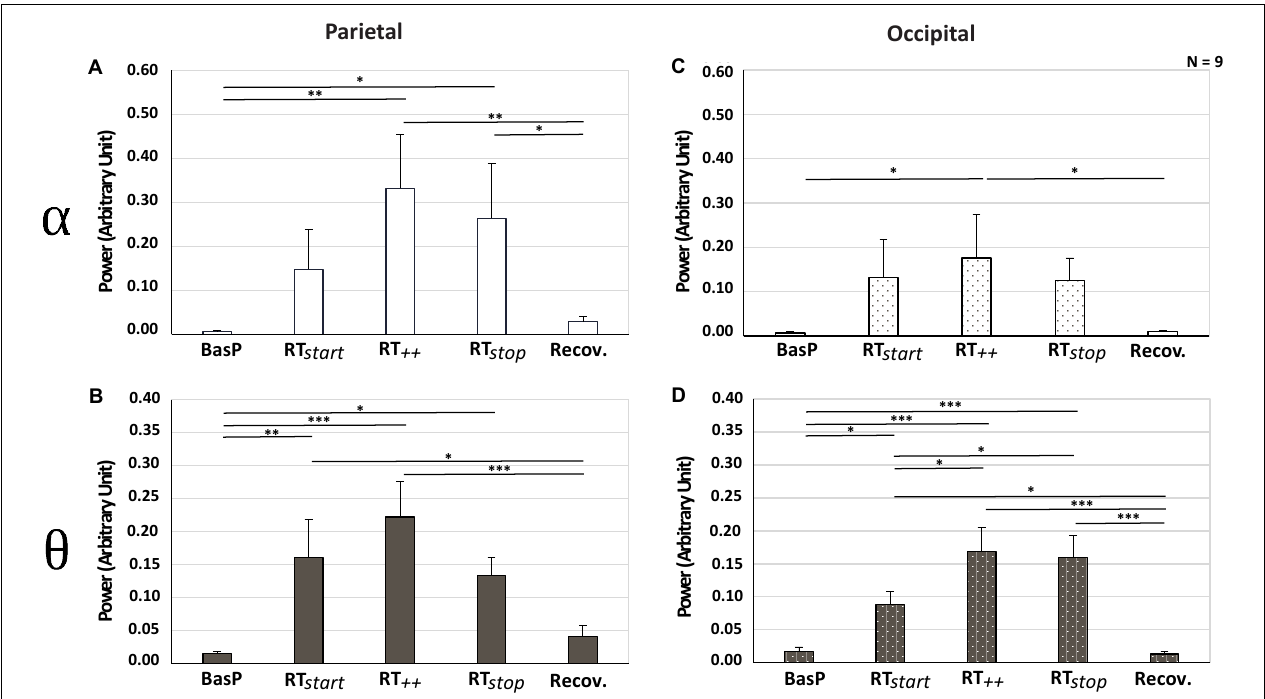
FIGURE 6 | Power observed in alpha (A–C) and theta bands (B–D) for parietal (A,B) and occipital areas (C,D) for each test period (BasP, RT start , RT ++ , RT stop and Recov) (mean ± SEM; n = 9; * p < 0.05, ** p < 0. 01, and *** p < 0.001 at risk α = 0.05).